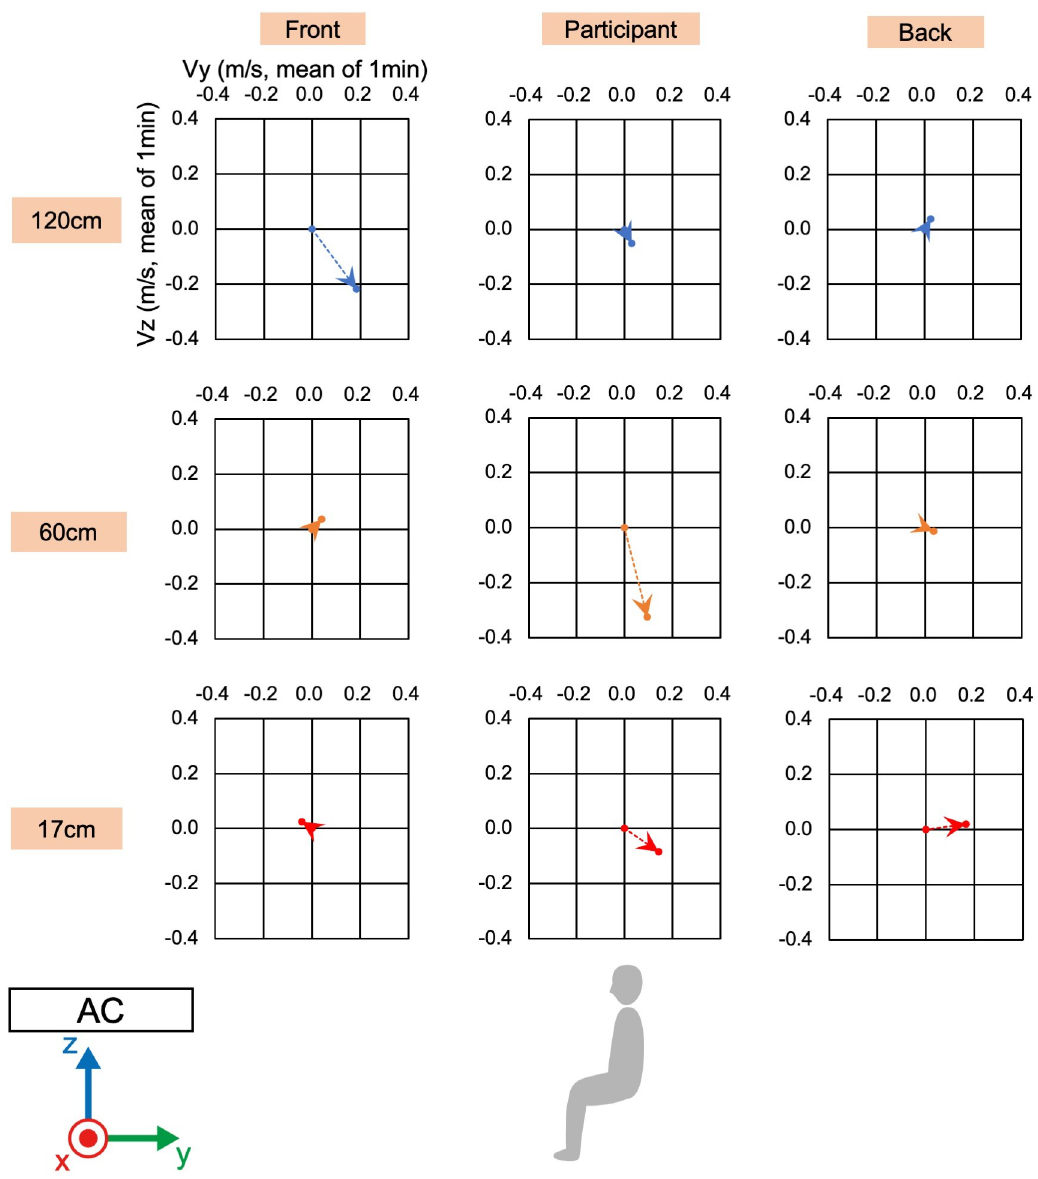
Fig 3. Wind velocity and direction in Y-Z plane of direct condition. Vy and Vz indicate the mean of the 1-min velocity in the Y or Z direction, respectively. Dotted lines indicate the vectors of the wind